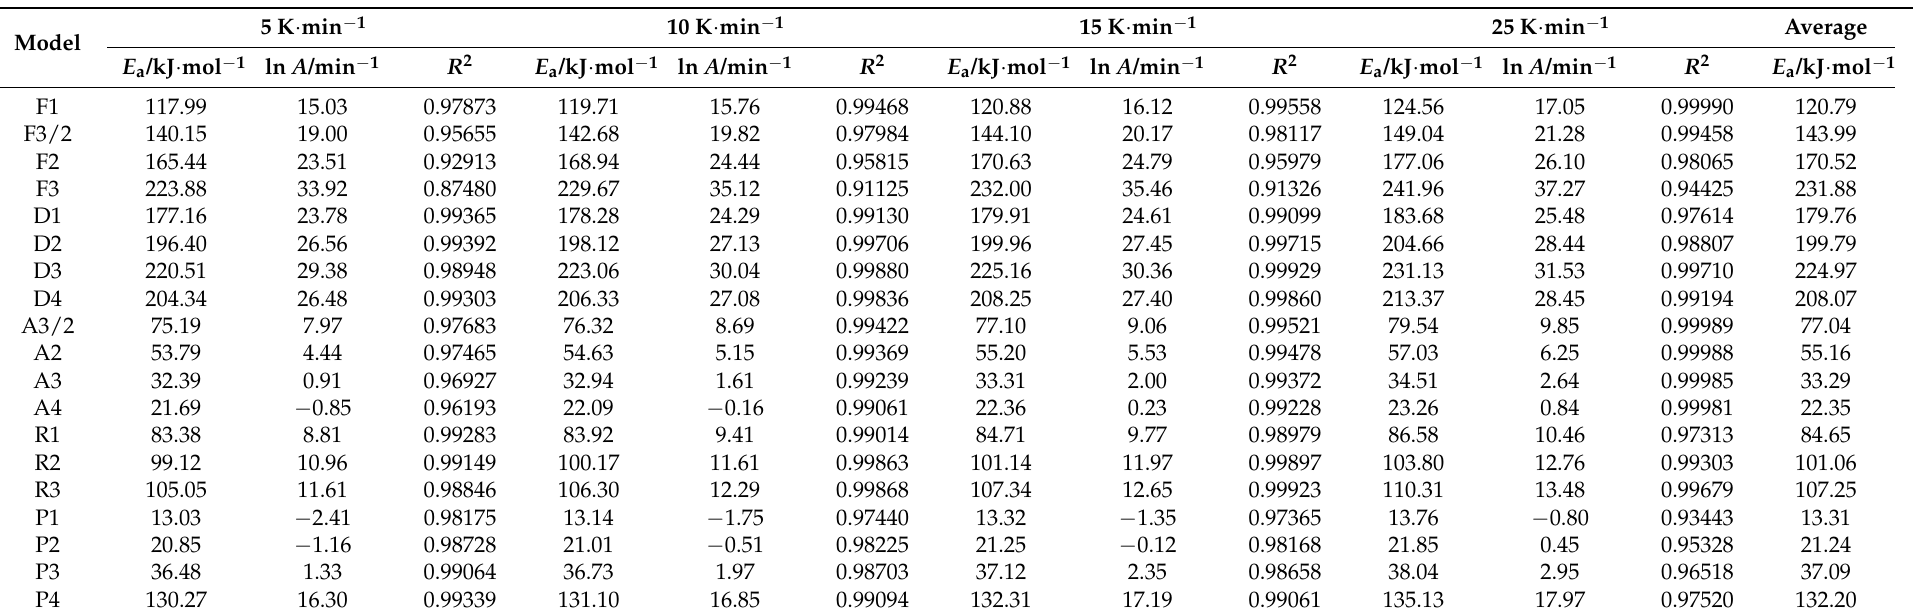
Table A6. The kinetic parameters of the second pyrolysis stage of NOC calculated by KC method at different heating